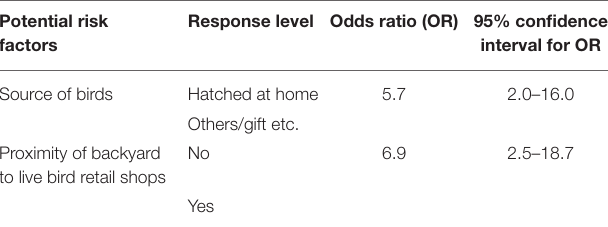
TABLE 4 | Results of final model with potential risk factors associated with the seroprevalence of AIVs in backyard poultry of villages of Lahore district. Potential risk Response level Odds ratio (OR) 95% confidence factors interval for OR Source of birds Hatched at